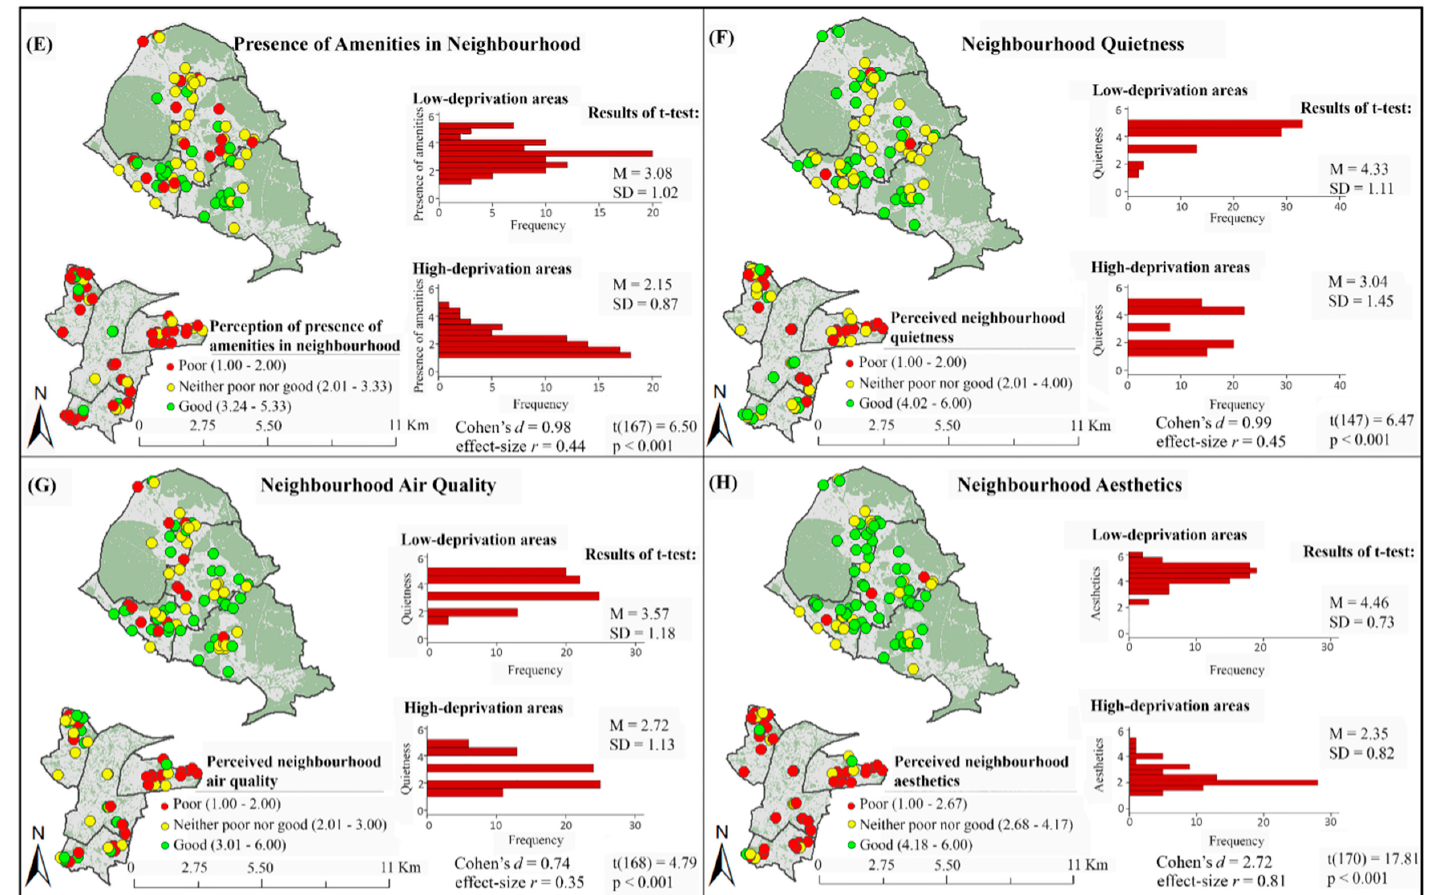
Figure 2. Disparities in outdoor walking levels and inequalities in perceived neighbourhood built environment attributes (OS open data Boundary-line © Crown copyright/database right 2012 and OS MasterMap data © Crown Copyright/database right 2012. An Ordnance Survey/EDINA Digimap supplied service). In all boxes of this figure, the image at the top shows low-deprivation areas and the image at the bottom shows high-deprivation areas. Frequency = number of participants; M = Mean; SD = Standard Deviation; t = t value.